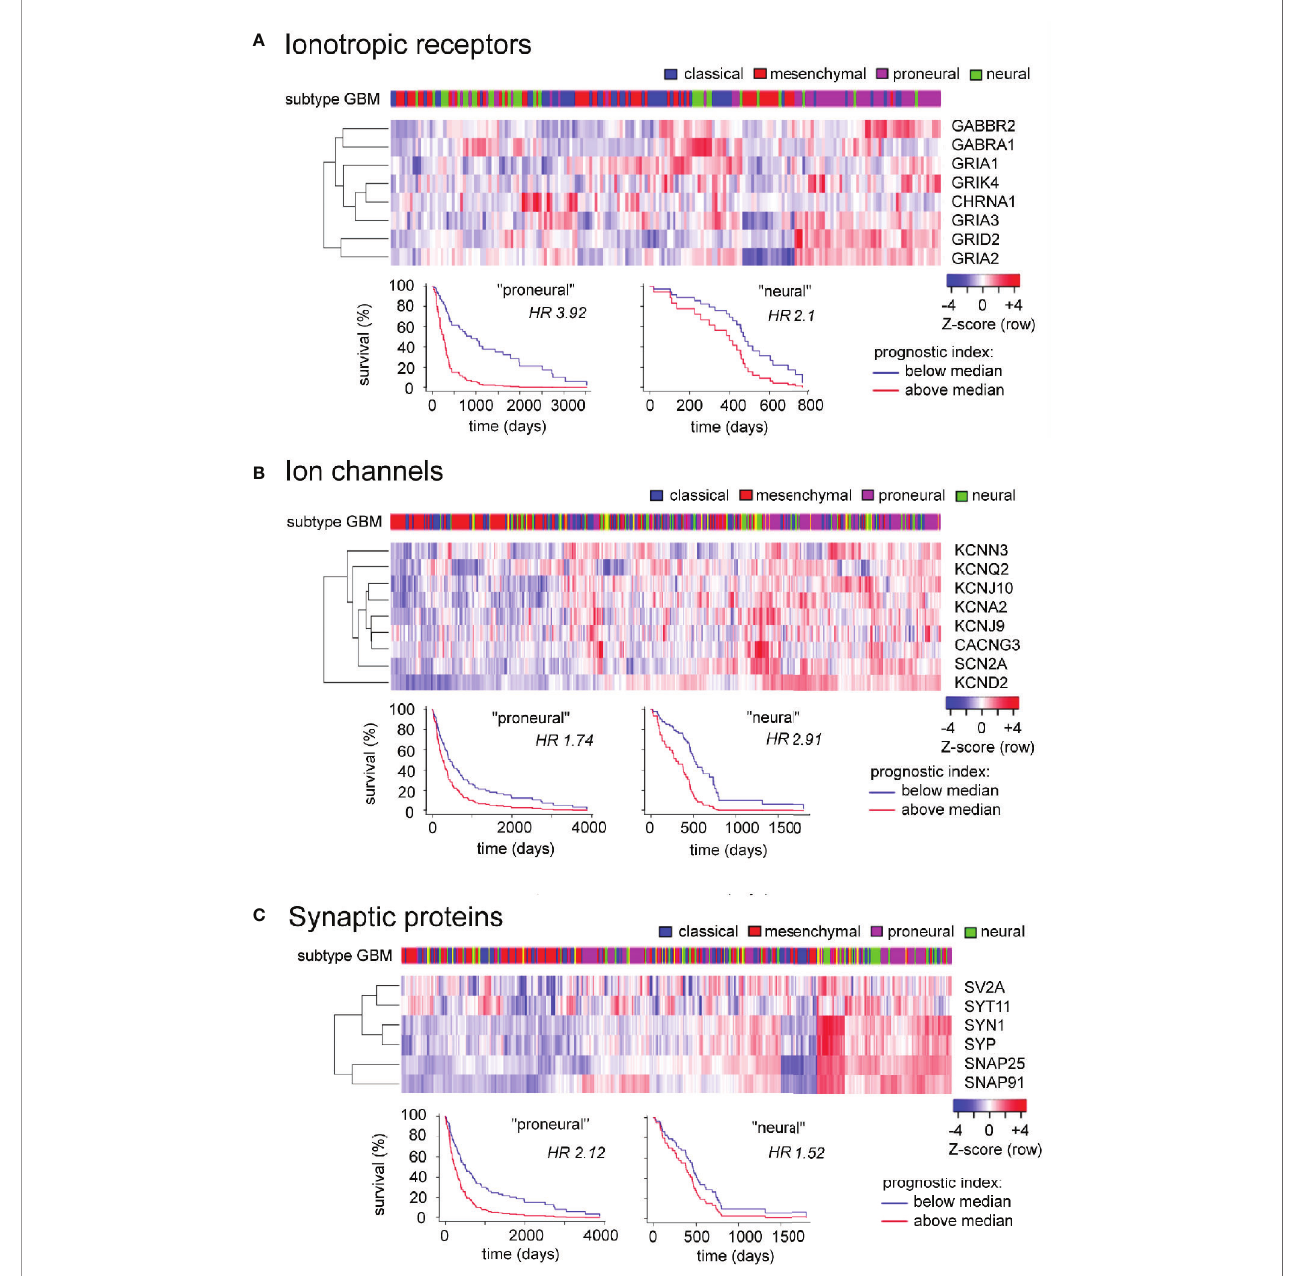
FIGURE 4 | Evaluation of expression patterns and additional prognostic information available in analyzing sets of related signaling genes, for ionotropic neurotransmitter receptors (A) , ion channels (B) , and synaptic proteins (C) enriched in glioblastoma. Data were analyzed using the GBM Bio Discovery Portal, a resource for user-speci fi ed interrogation of The Cancer Genome Atlas (TCGA) database, for glioblastoma multiforme categorized by molecular subtype (Verhaak et al., 2010). GBM, glioblastoma